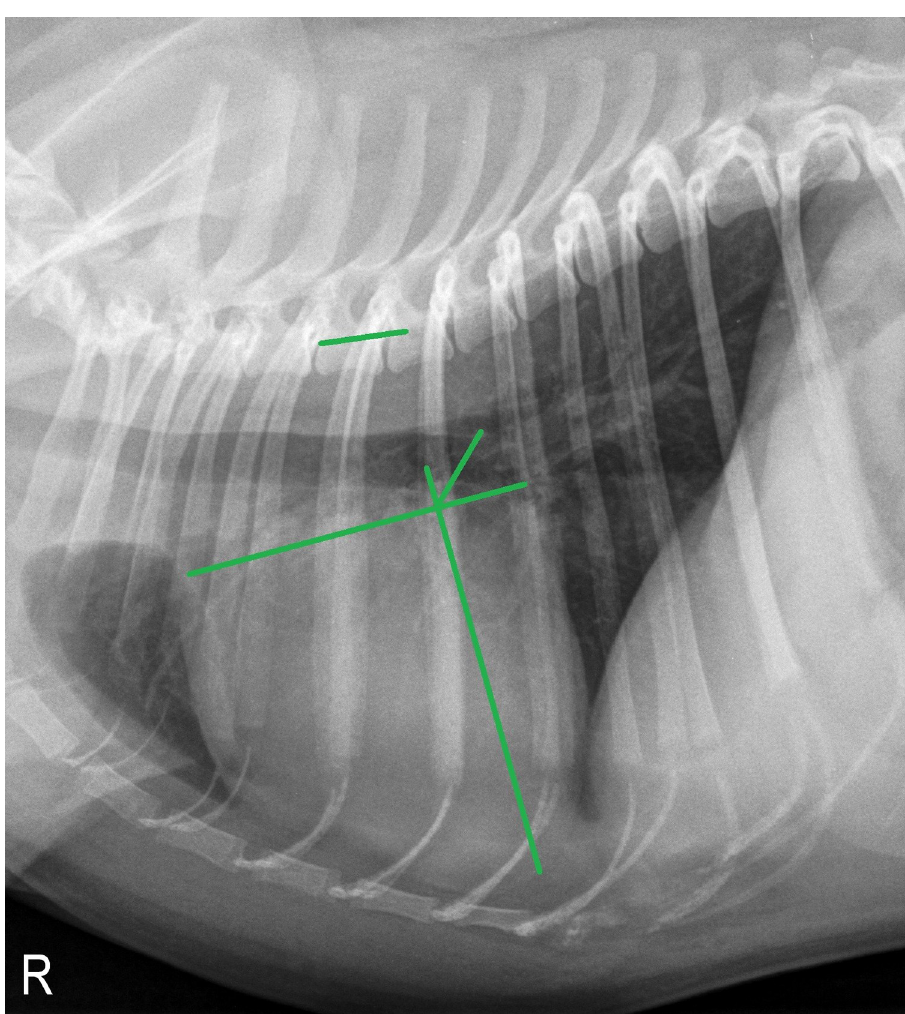
Fig 3. Measurement of radiographic left atrial dimension (RLAD) in a right lateral thoracic radiograph of the same two-year-old male pug as in Figs 1 and 2, being 1.3v in this